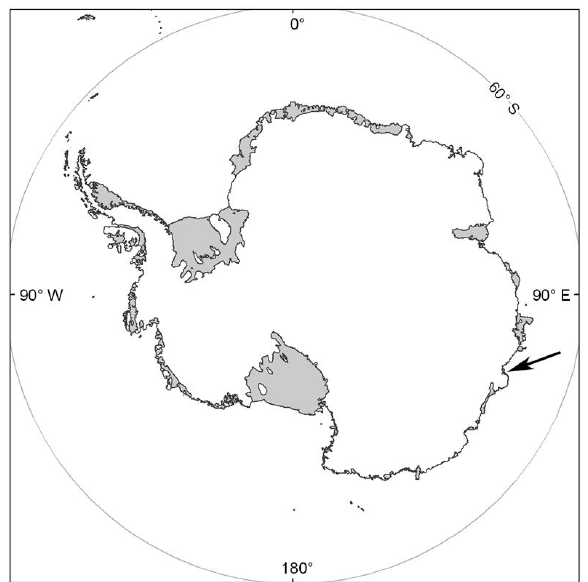
Figure 1: Study area: the continent of Antarctica with an arrow in Eastern Antarctica indicating the location of the Windmill Islands (source: Australian Antarctic Data Centre).